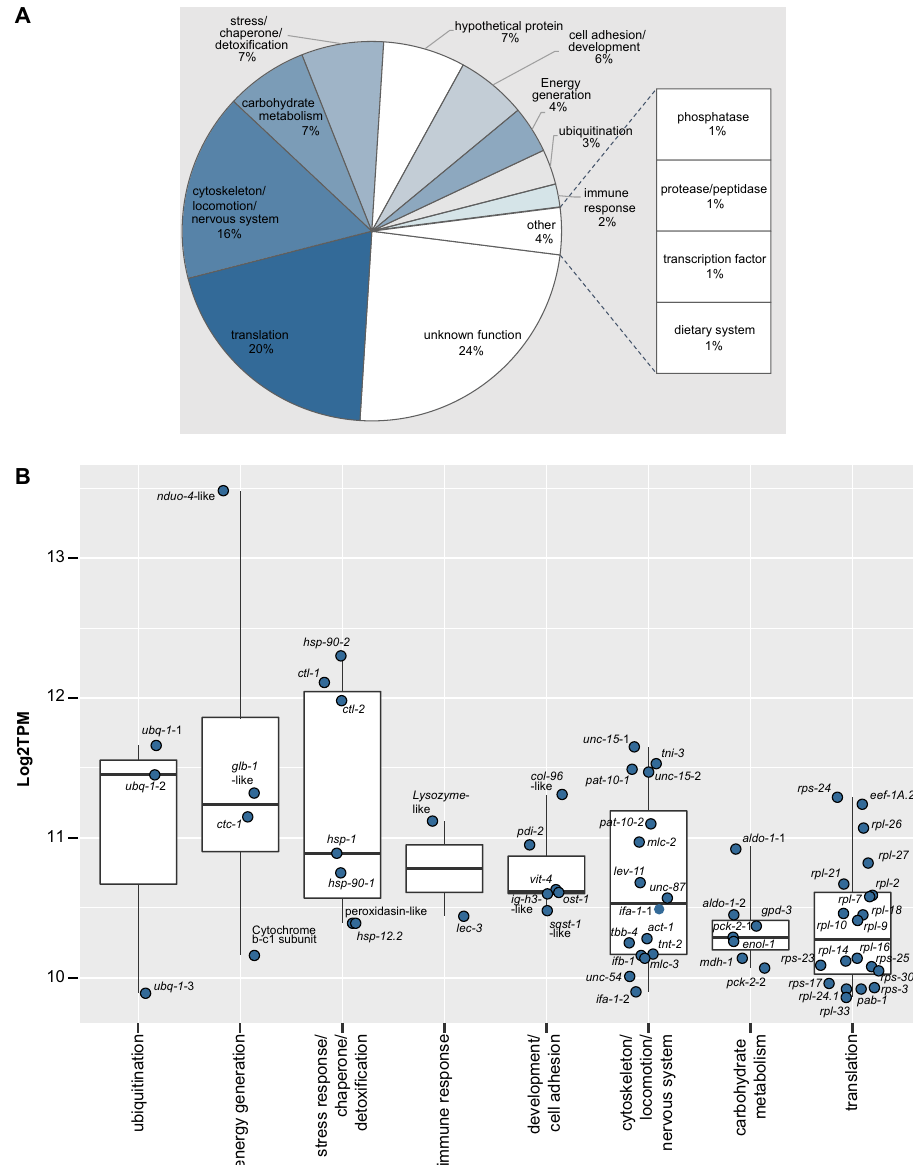
Figure 1. Relative transcript abundance and expression levels of the top 100 expressed genes of L. oneistus across all conditions. (A ) Relative transcript abundance (%) of the top 100 expressed genes with a manually curated functional category. The top 100 expressed genes were collected by averaging the expression values (log 2 TPM) across all replicates of all incubations (Fig. S1A, Data S1, and S2). Functional classifications were extracted from UniProt and from comprehensive literature search focused mainly on C. elegans, and confirmed with the automatically annotated eggNOG classification (Data S1). ( B ) Median gene expression levels of selected L. oneistus manually annotated functional categories of the top 100 expressed genes. Metabolic processes include both differentially and constitutively expressed genes. Each dot represents the average log 2 TPM value per gene across all replicates of all incubations. All gene names (or locus tags for unidentified gene names) are listed in Data